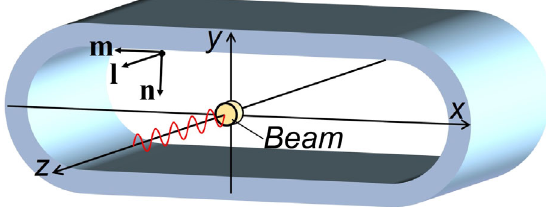
FIG. 1. A relativistic charged particle beam with transversally uniform charge density moving at constant velocity on the axis of an infinitely long vacuum chamber with a racetrack-type cross